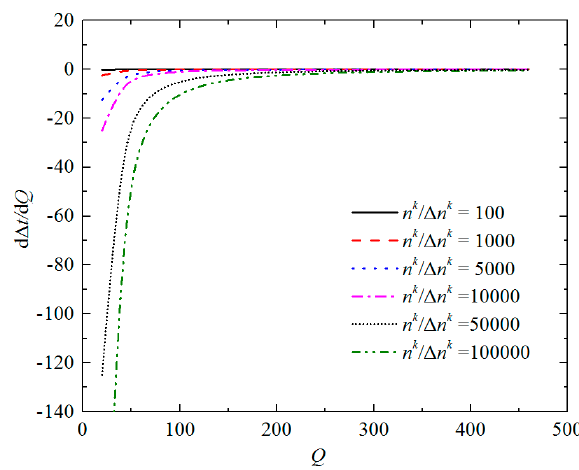
Figure 3. The first derivative curves of Equation (31) with respect to Q with using different n k / Δ n k values.